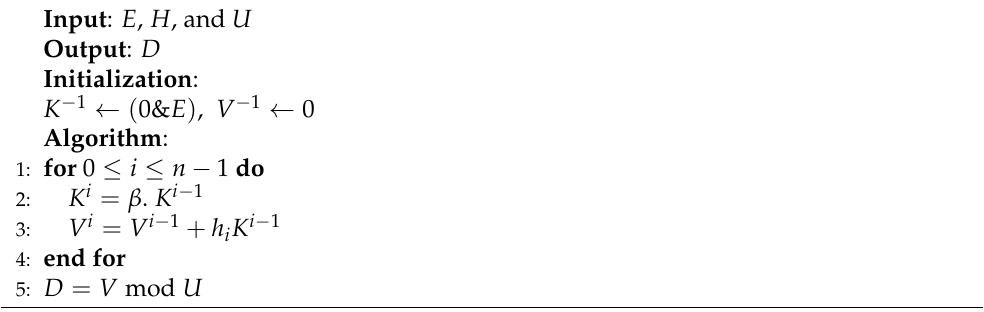
Algorithm 1 Finite Field Multiplication Algorithm based on AOP polynomial.